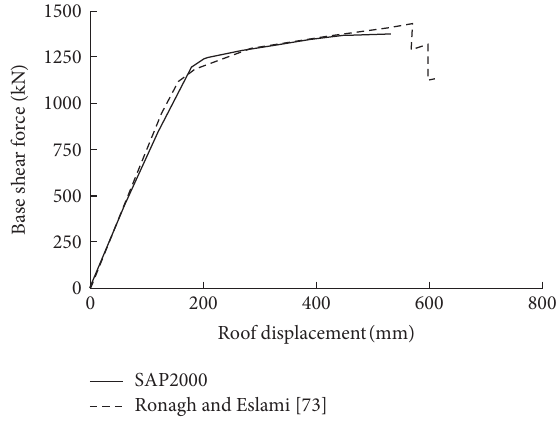
Figure 10: Comparison of pushover